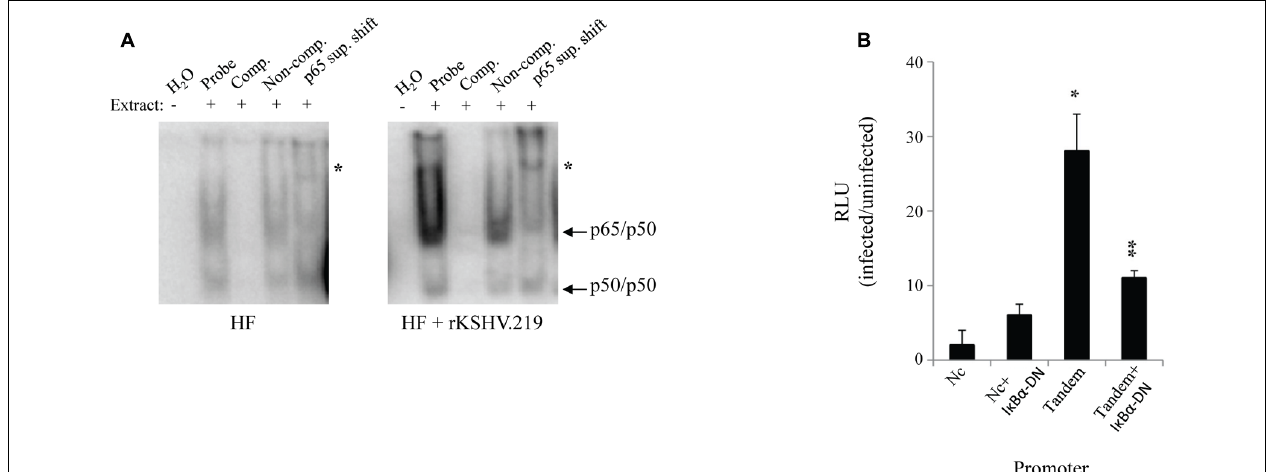
FIGURE 1 | rKSHV.219 leads to constitutive NF κ B activation in HF. (A) HF cells were either mock infected or infected with rKSHV.219 at a MOI of 10. At 72 h post-infection 2 x 10 5 cells were harvested and 2 uL of nuclear extracts were characterized by EMSA using an NF κ B–specific radiolabeled probe. Lane 1, H 2 O; 2, Nuclear extract (NE); 3, cold NF κ B 50-fold molar excess probe (Comp.); 4, Non-competitive probe (Non-comp.); and 5, super shift with an anti-p65 antibody (p65 sup. Shift; *). Arrows denote protein subunits p50 and p65.This is a representative of three separate experiments. (B) HF cells were transfected with NF κ B-driven luciferase plasmids: pF-Luc,